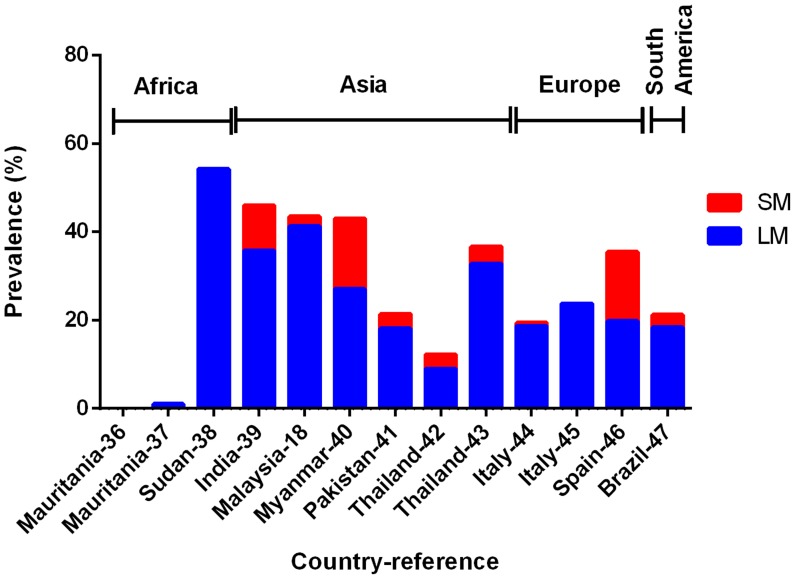
Prevalence of LM (light microscopy, blue bar) and SM (sub-microscopy, red bar) P. falciparum in clinical malaria suspects.Total height of bar (blue + red) represents PCR prevalence.